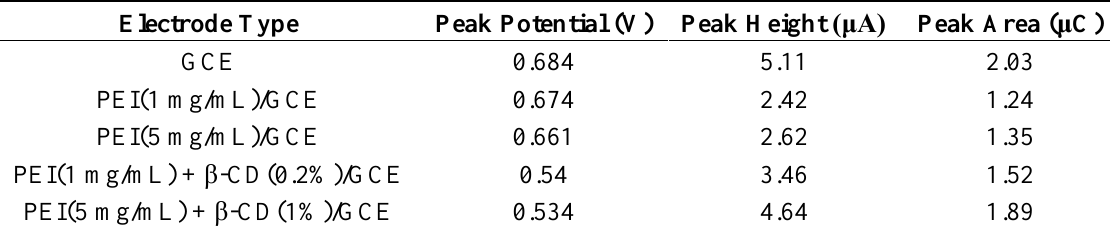
Table 1. SWV parameters for 10 −3 M UA on different electrodes.